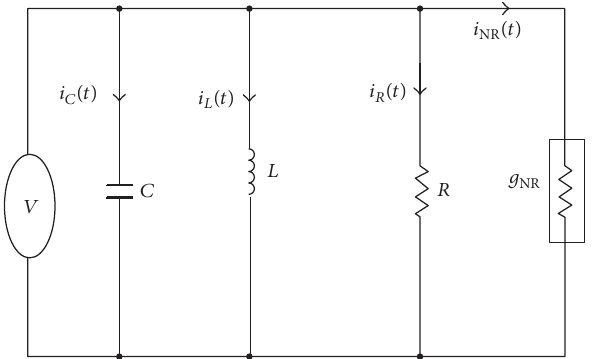
Figure 3: Schematic circuit of Van der Pol